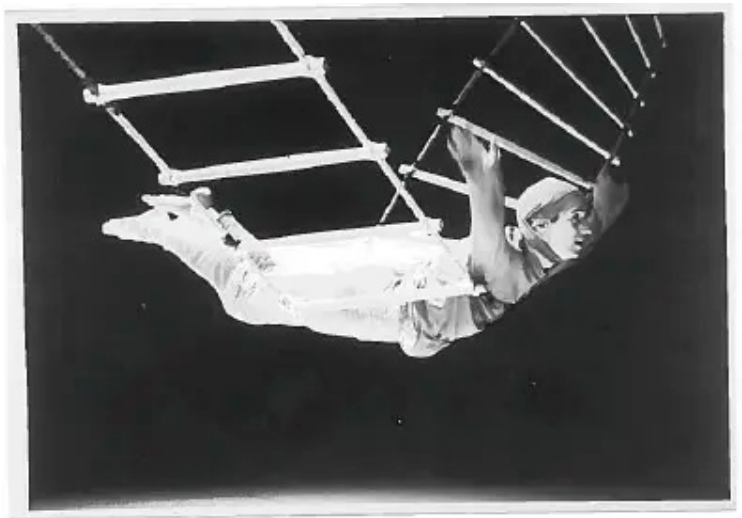
Figure 5. Les Palets —photo from the Frenak Archive.